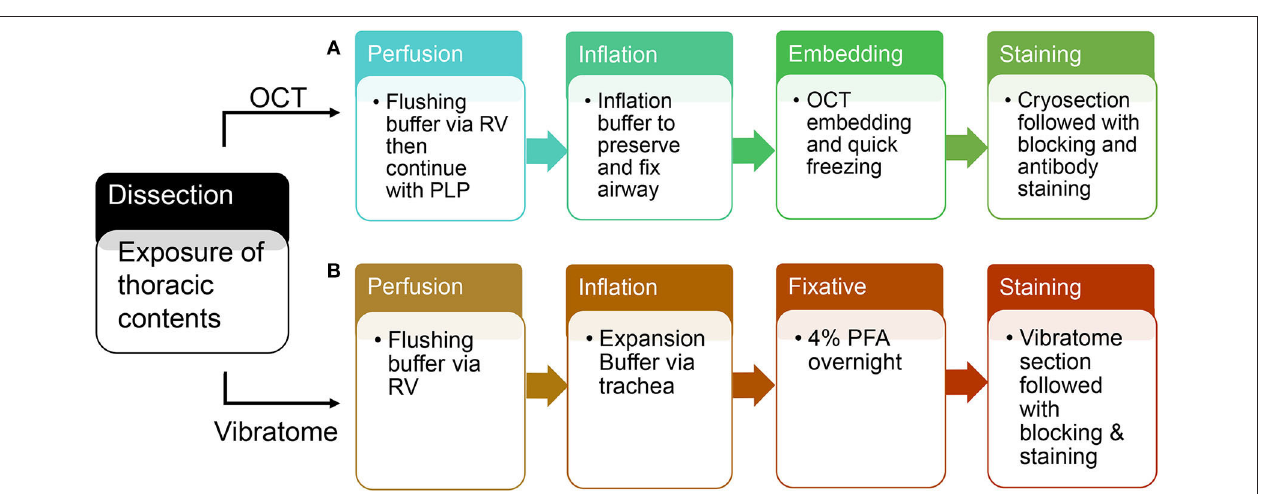
primary/secondary antibodies in antibody dilution buffer,